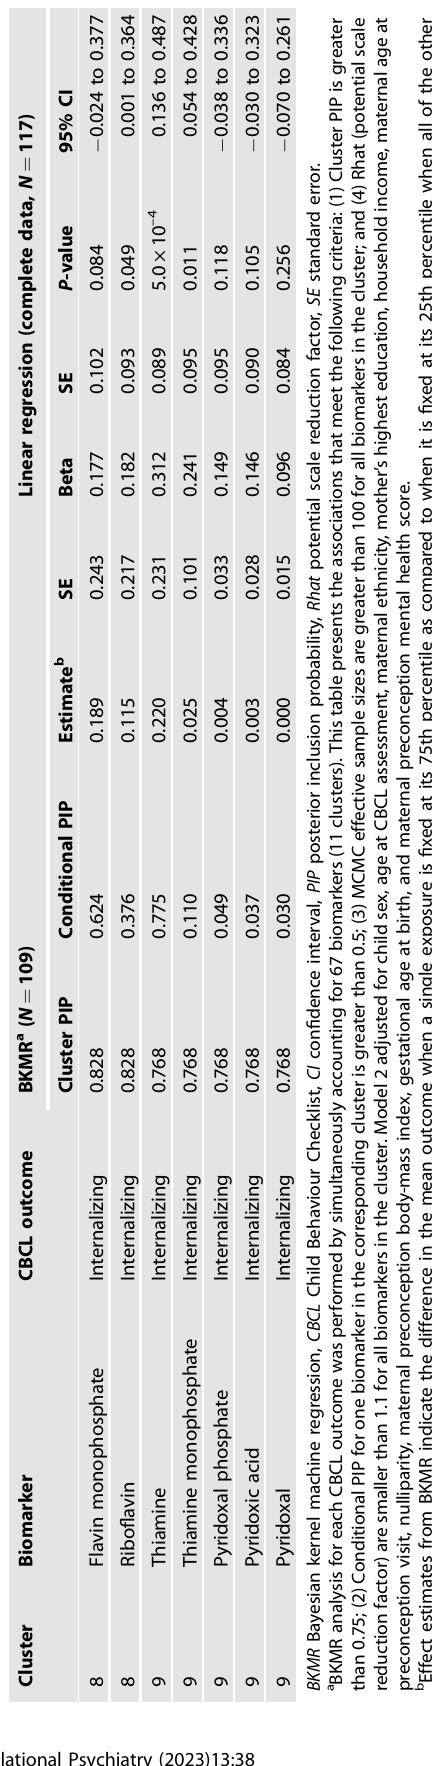
Supplementary Table 6; thiamine: Cluster PIP = 0.946, Condi- tional PIP = 0.958,